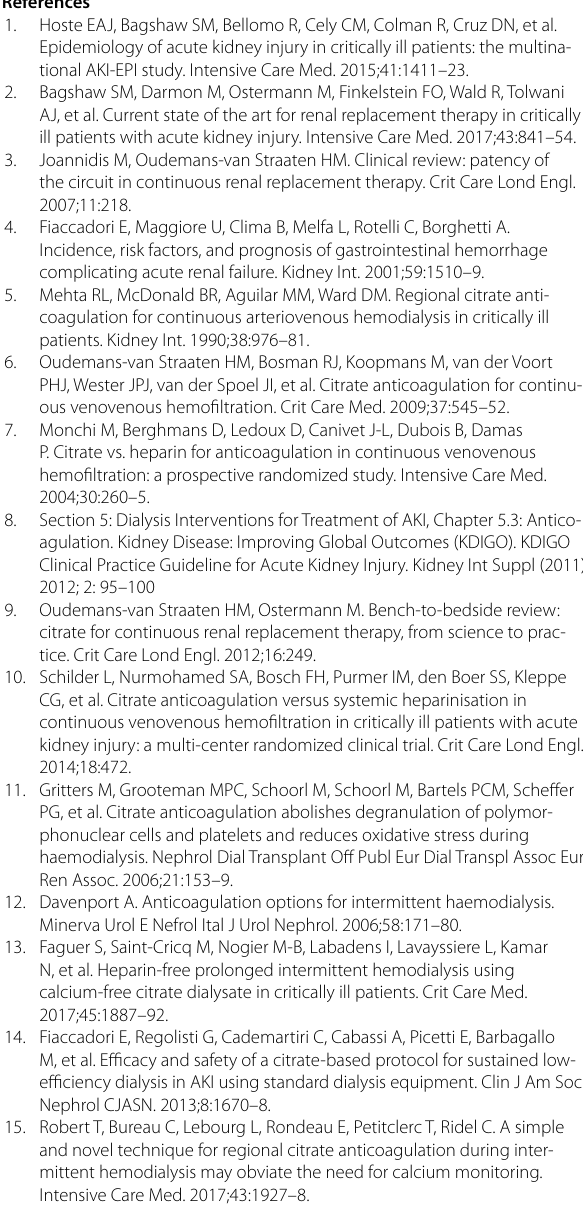
Additional file 1 : Figure S1. Schematic representation of regional citrate anticoagulation for intermittent hemodialysis. Additional file 2 : Table S1. Characteristics of patients in the two study